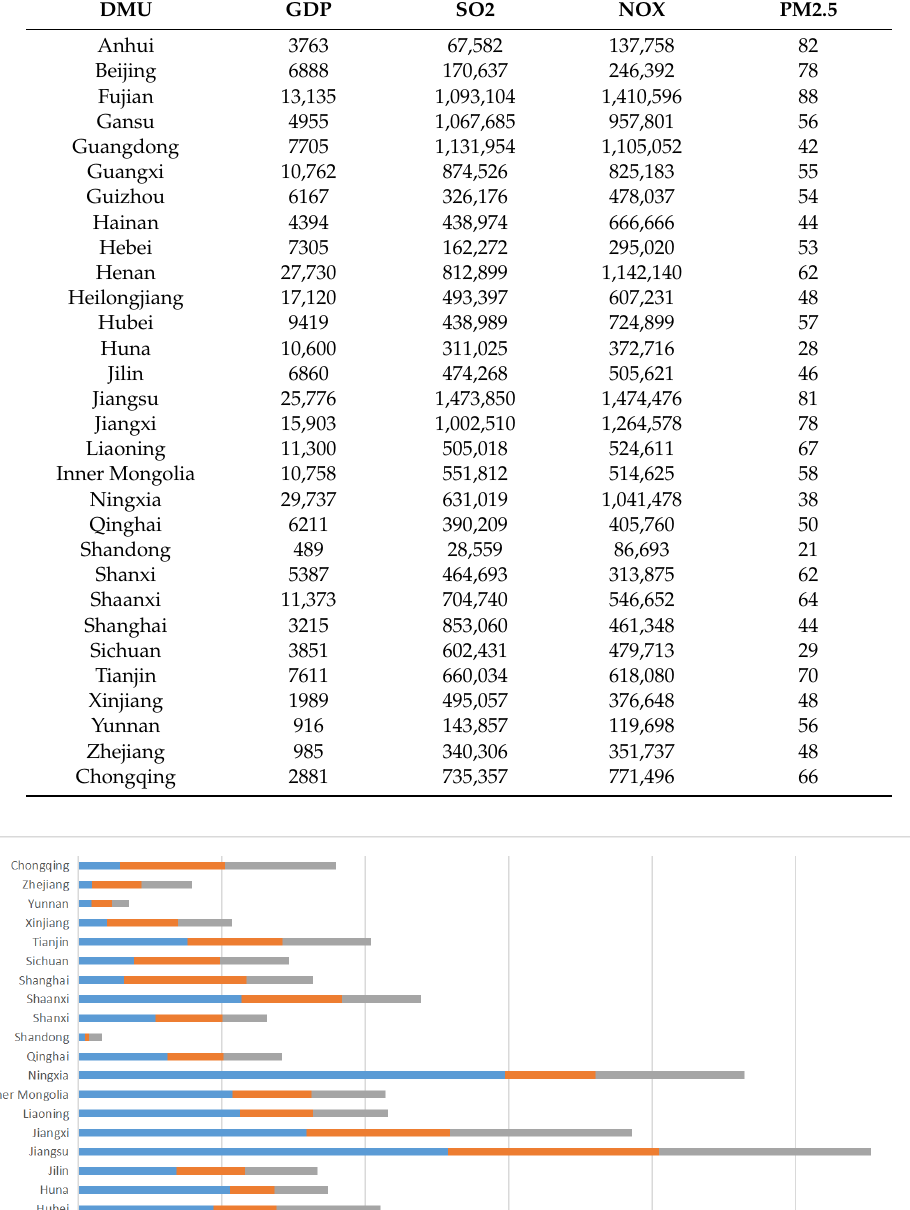
Table A3. The four-year average output value of the output indicator.